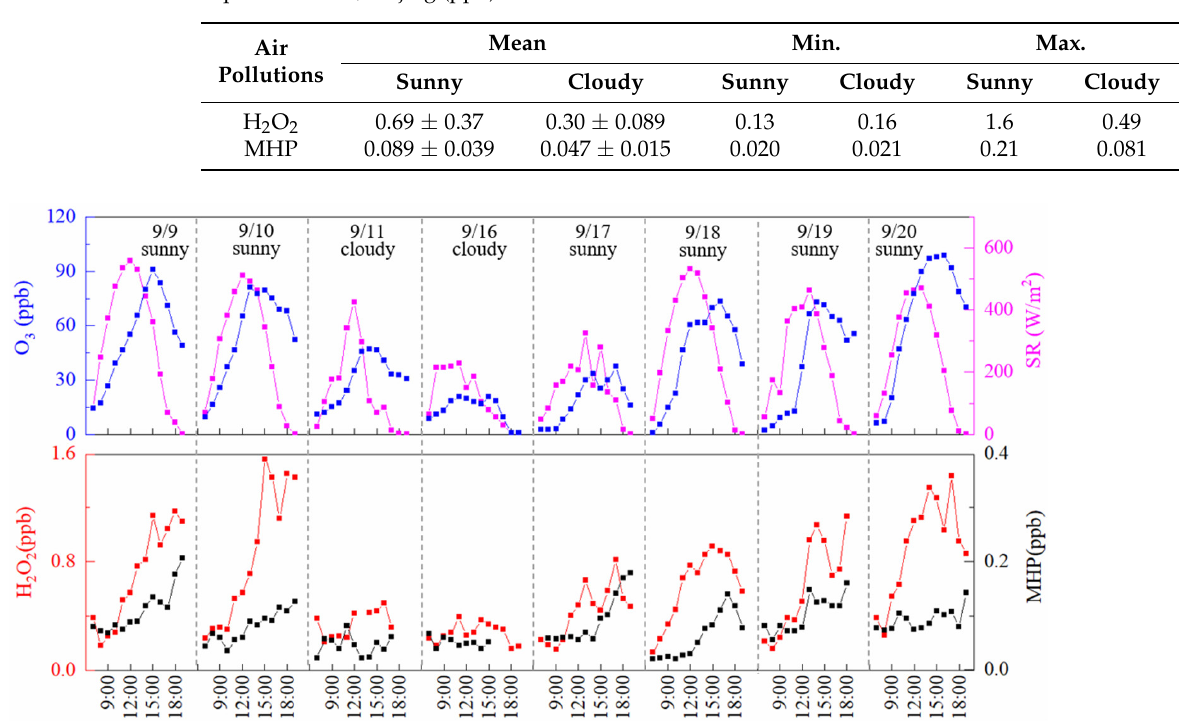
Table 8. Concentrations of H 2 O 2 and MHP were observed on sunny days and cloudy days in September 2016, Beijing (ppb).